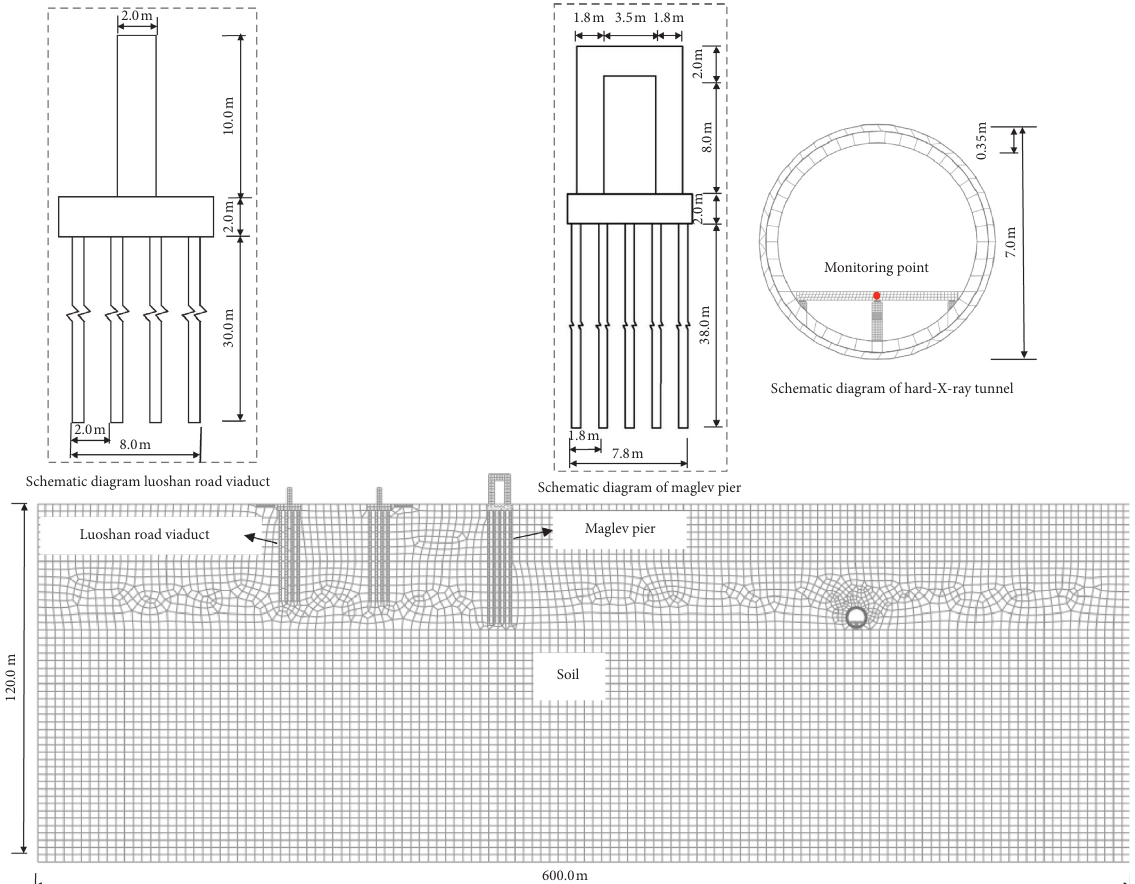
Figure 26: FE model.